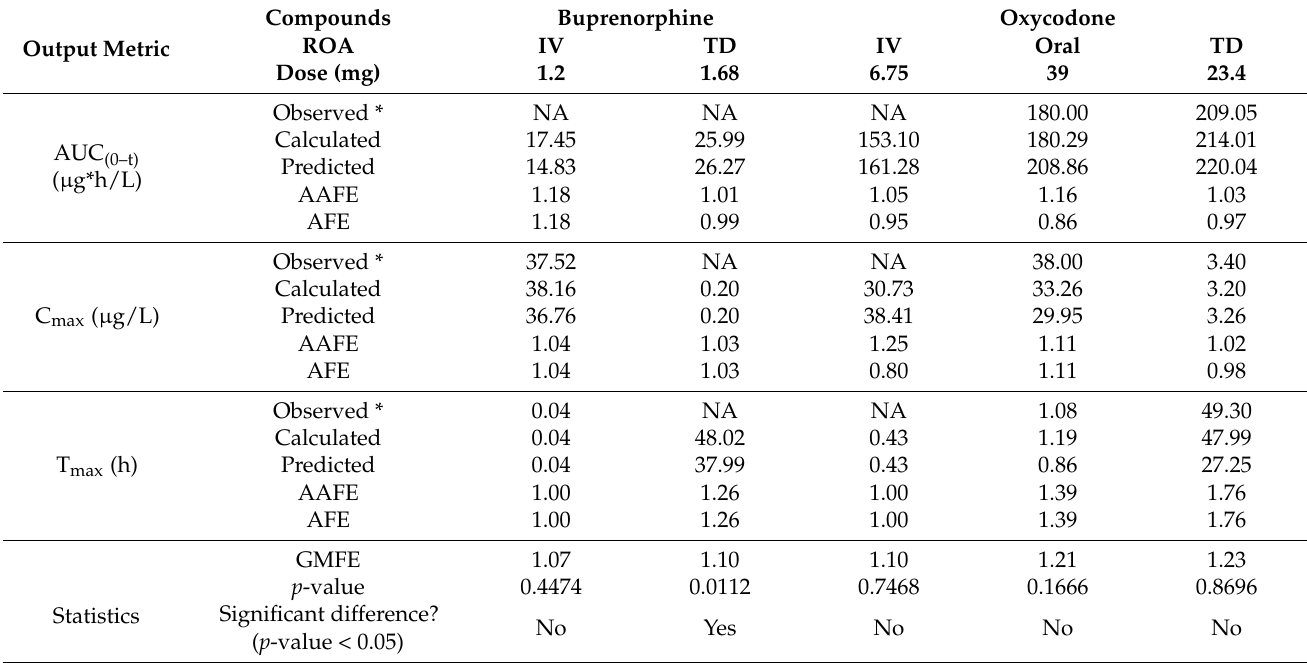
Table 3. Comparison of model predicted outputs to experimental